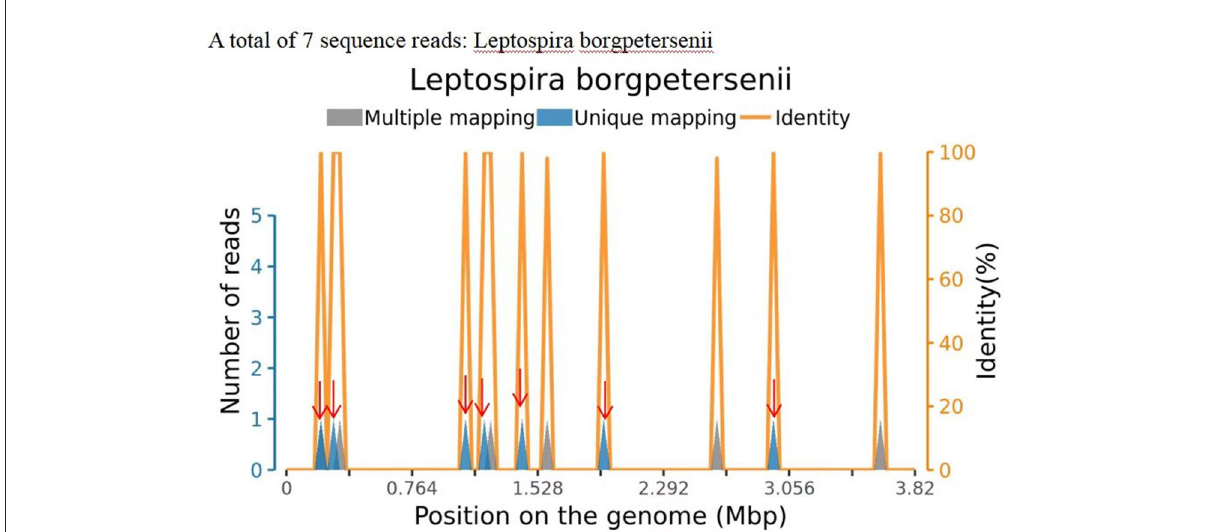
FIGURE1 Sequence reads of Leptospira borgpetersenii , derived from the patient’s cerebrospinal fluid (CSF) specimen and the Leptospira genome in the reference database. The coverage map shown above is a mapping for a specific microorganism, reflecting the distribution of the sequence of the microorganism on its genome; the abscissa represents the size of the microbe’s gene group; and the ordinate represents the number of sequences detected in different genomic segments.